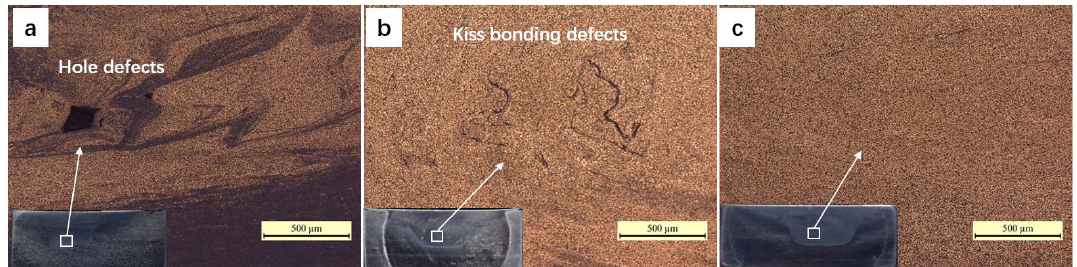
Figure 5. Local magnifications of nugget at diverse process parameters: ( a ) ν 300 mm/min and ω 1250 rpm with one-pass processing; ( b ) ν 300 mm/min and ω 1000 rpm with one-pass processing; ( c ) ν 300 mm/min and ω 1000 rpm with two-pass processing.